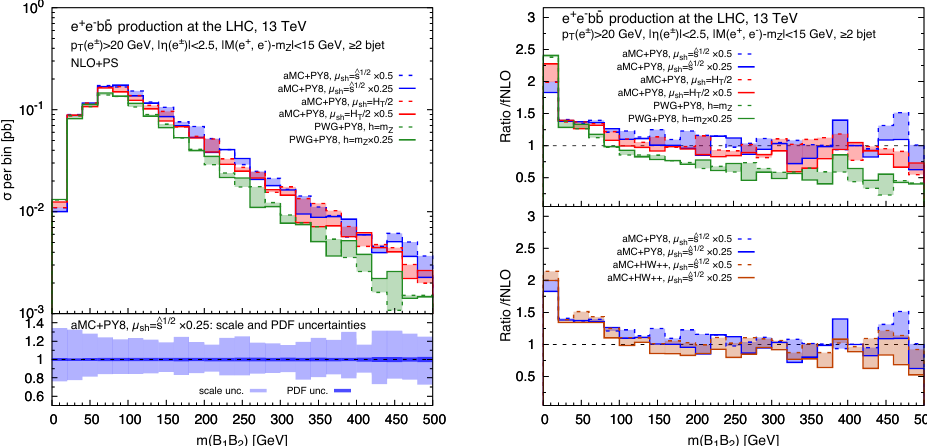
Figure 22 . Invariant mass distribution of the B hadrons pair in association with at least 2 b jets.